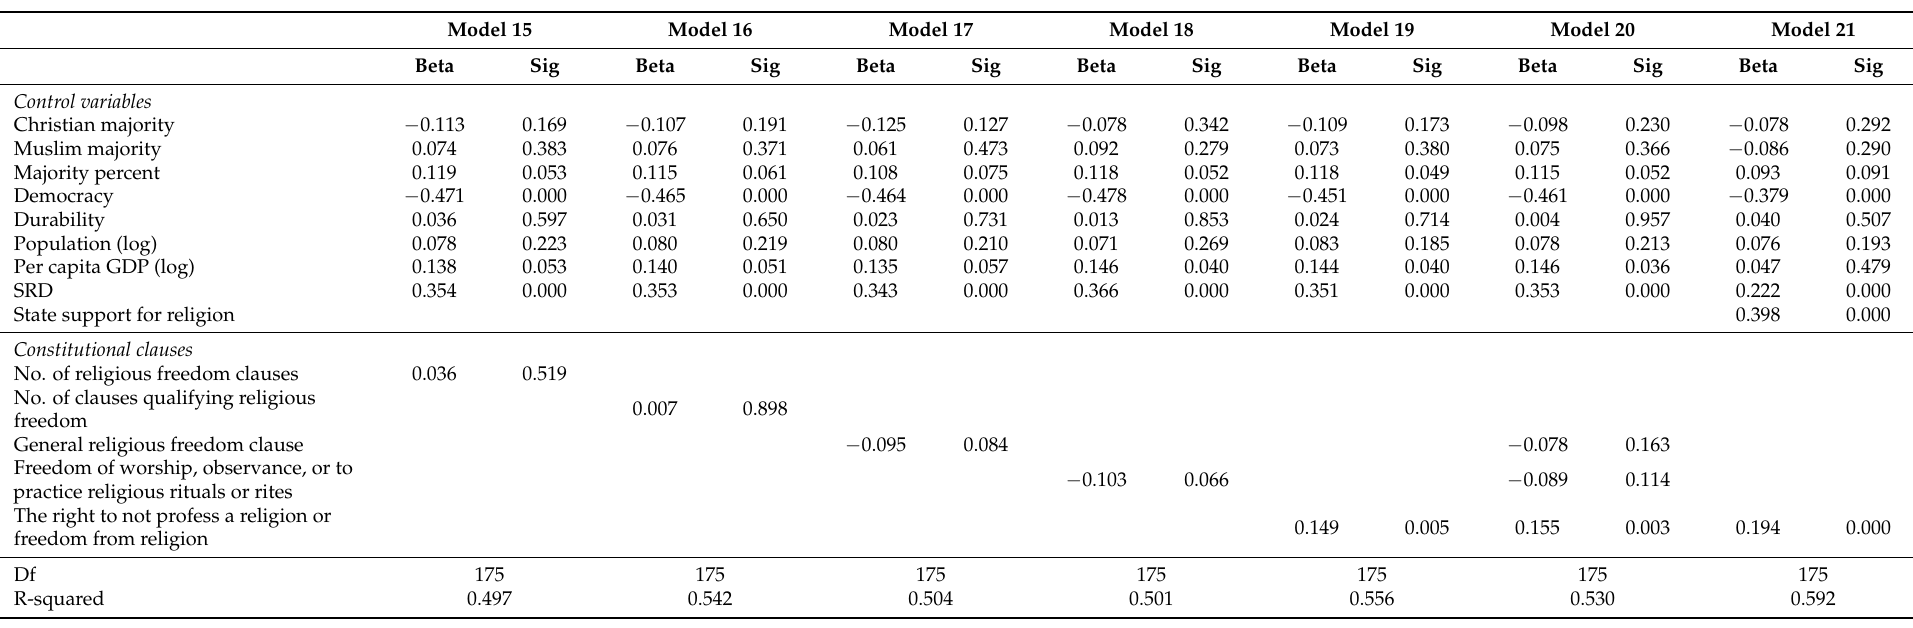
Table 11. OLS regressions predicting the influence of religious freedom clauses on GRD in